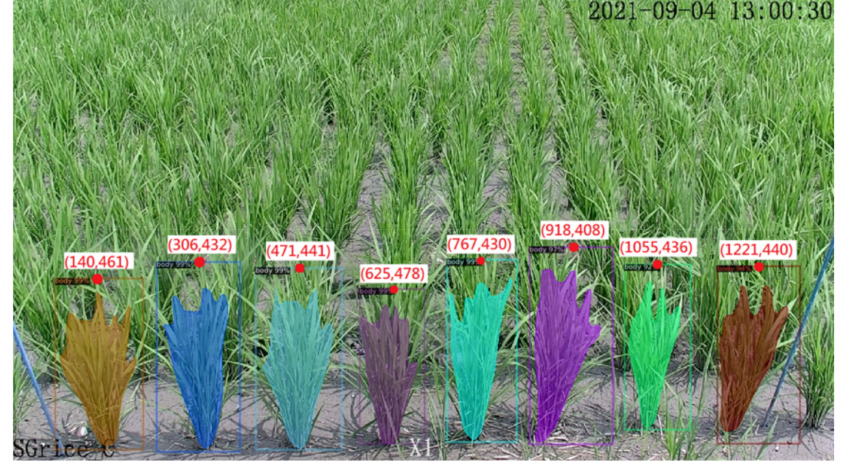
Figure 7. The Coordinates of Paddy Instances Predicted by Instance Segmentation